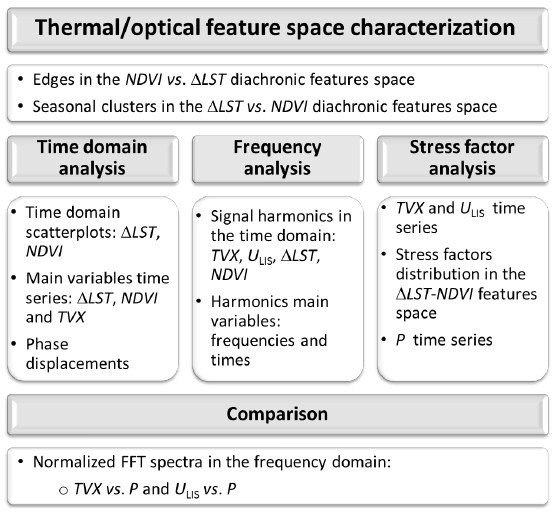
Figure 3. Methodology structure.